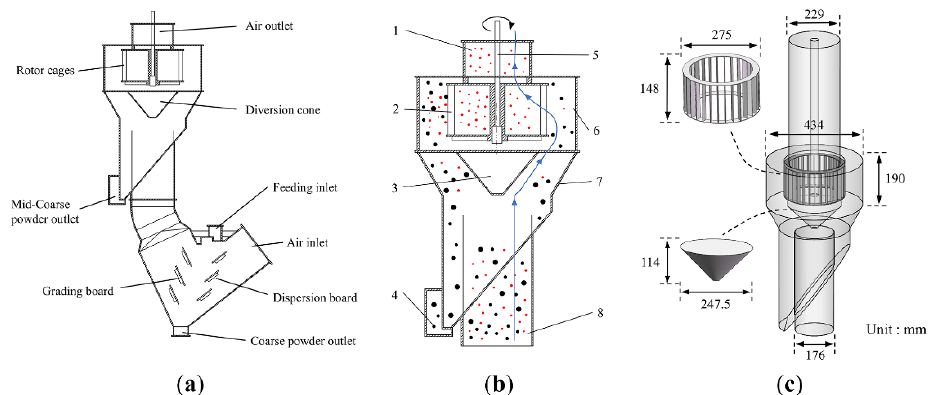
Figure 1. The new high-efficiency three separation classifier: ( a ) geometry, ( b ) parts, and ( c ) dimensions of the new rotor-type dynamic classifier; 1—air and fine outlet, 2—rotor cage, 3—diversion cone, 4—coarse powder outlet, 5—transmission shaft, 6—classification chamber, 7—cone, and 8—feeding and air inlet.